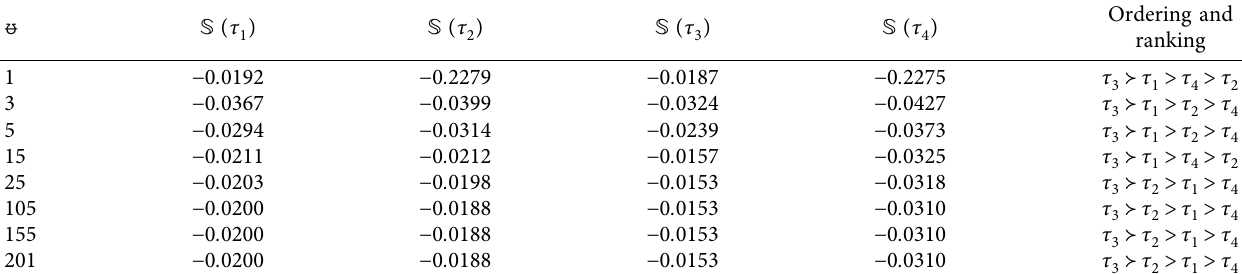
Table 4: Ranking and score values by IVPFAAWG operators with various ᵿ .